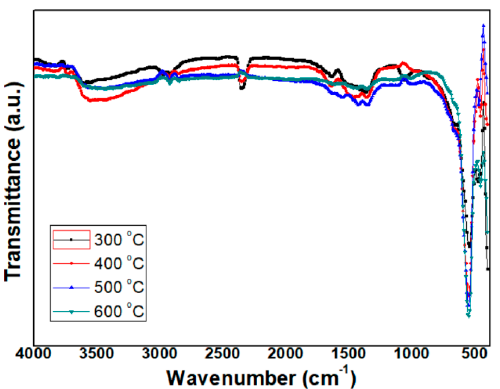
Figure 7. FT-IR spectra of NiO NPs heat-treated at various temperature.